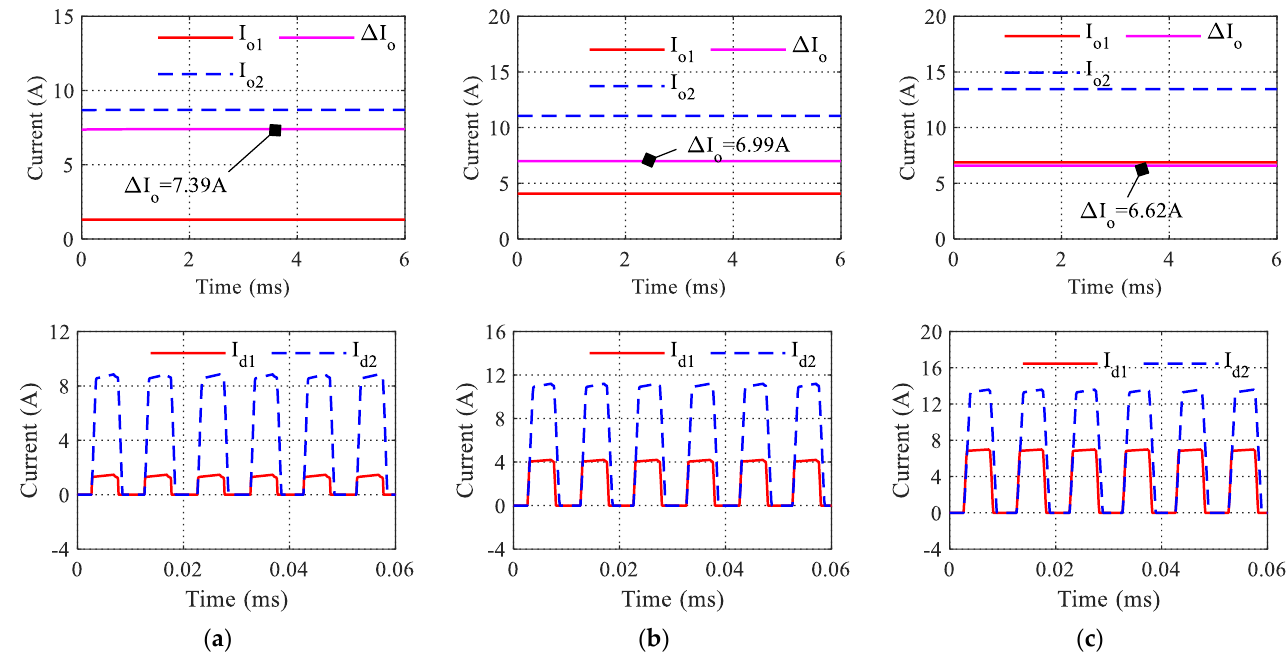
I and in different Figure 18. Simulation result of Figure 18. Simulation result of I o and I d in different P o without current sharing control when c = 1.2: o ( a ) R o = 4 Ω , P o = 400 W; ( b ) R o = 2.667 Ω , P o = 600 W; ( c ) R o = 2 Ω , P o = 800 W. Current Sharing Control Result when c = 1.2